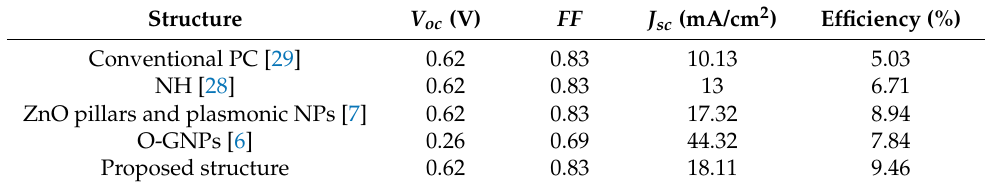
Table 5. V oc , FF , J sc , and PCE for different related nanostructures compared to the proposed